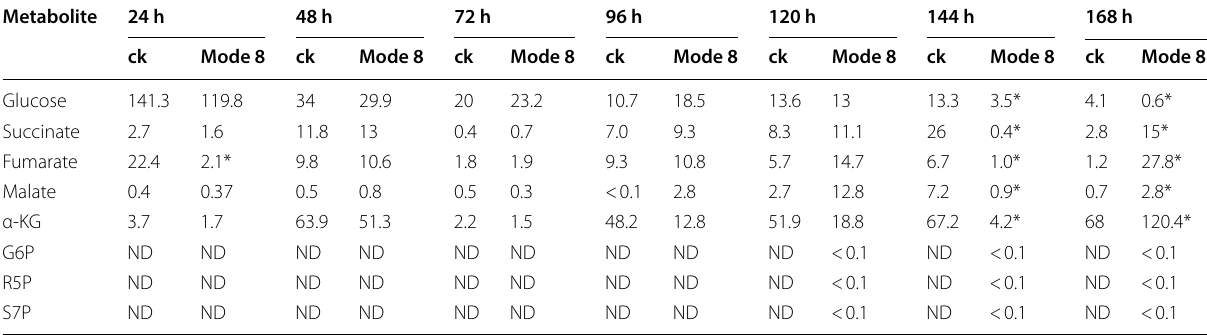
ND represents undetectable; “< 0.1” represents the concentration is lower than the detection limits of 0.1 µmol/g DCW * Represents p < 0.05